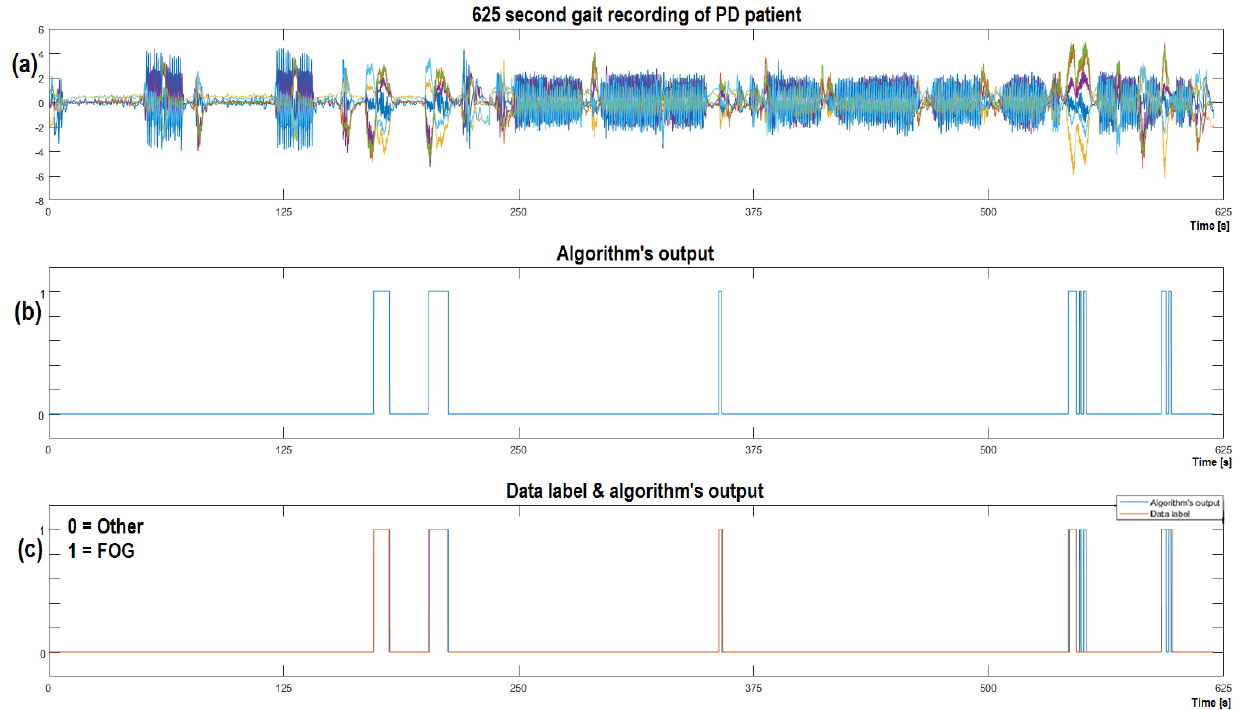
Figure 11. Visualization of the CNNA + RNN algorithm’s output on the test CWT dataset of the PD patient, that experienced five FOG episodes; ( a ) Complementary filter information visualized from an ‘unseen’ gait dataset; ( b ) illustrates the algorithm’s output on the ‘unseen’ dataset; ( c ) presents a comparison of the data label and the algorithm’s output.